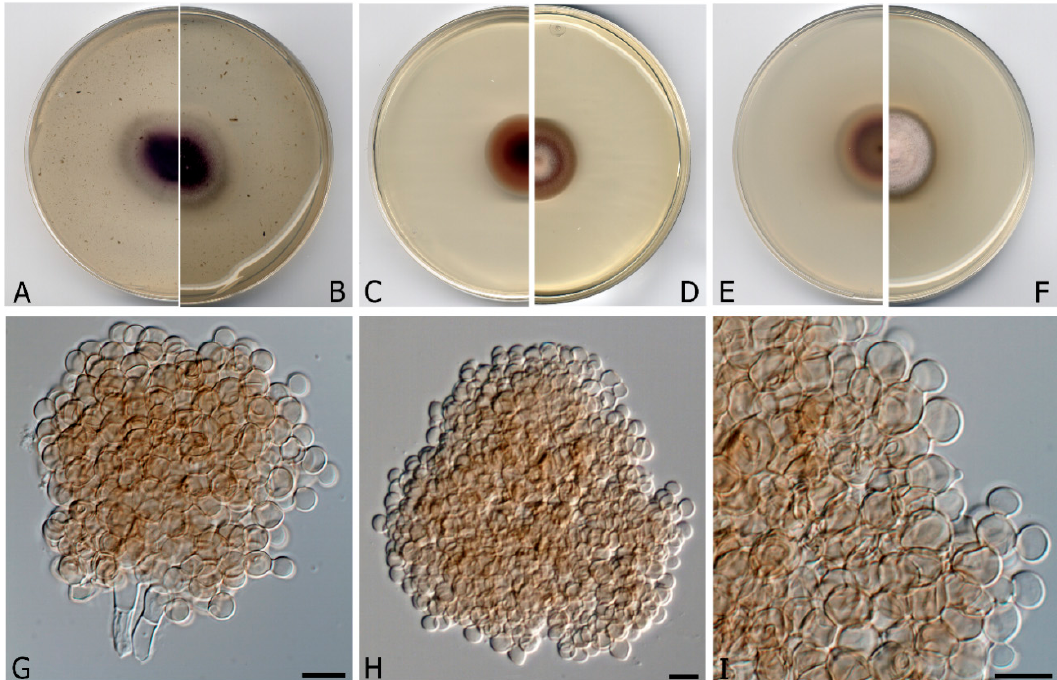
Figure 2. Fouskomenomyces mimiticus CBS H-24461. ( A , B ) Colonies on OA (oatmeal agar; reverse and front), ( C , D ) MEA (malt extract agar) 2% (reverse and front), ( E , F ) PDA (potato dextrose agar; reverse and front), at 20 °C after 3 weeks. ( G ) Conidial propagules with attached conidiogenous cells. ( H ) Free propagule. ( I ) Detail of a propagule showing the budding-like cells. Scale bars = 10 µm. Etymology . From Greek μιμητικός , mimetic, because the morphological resemblance to other